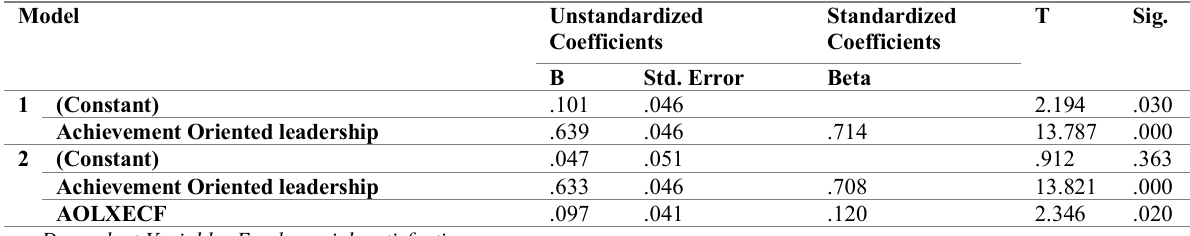
Table 10: Regression coefficients for achievement-oriented